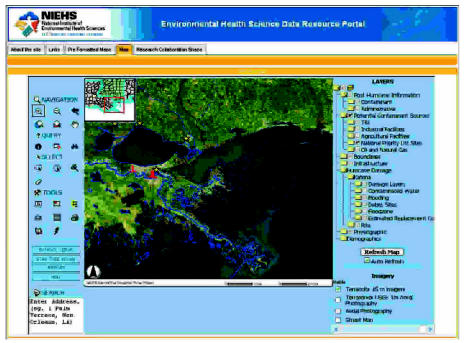
NIEHS Portal GIS.